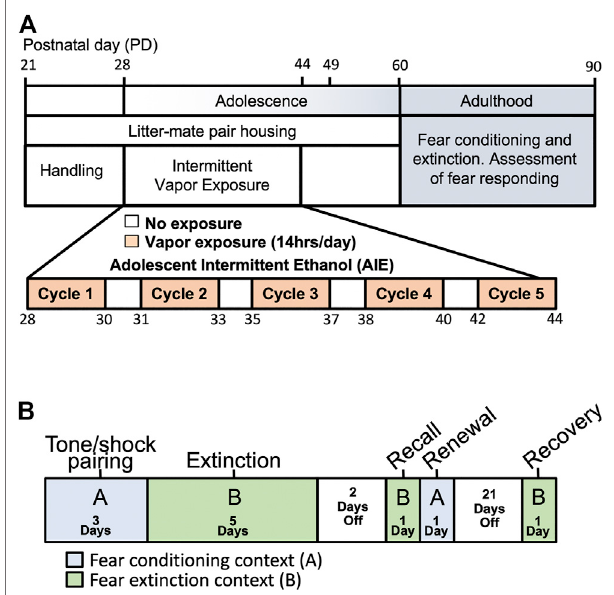
FIGURE 1 | Schema of experimental time-line and procedures. (A) Pair- housed adolescent male and female rats were subjected to 5 cycles of either Air (control) or ethanol vapor beginning at PD28 and ending at PD44. Rats were then allowed to age to adulthood when behavioral testing was initiated. (B) An ABBAB contextual design was used to examine fear conditioning, extinction, recall, renewal and spontaneous